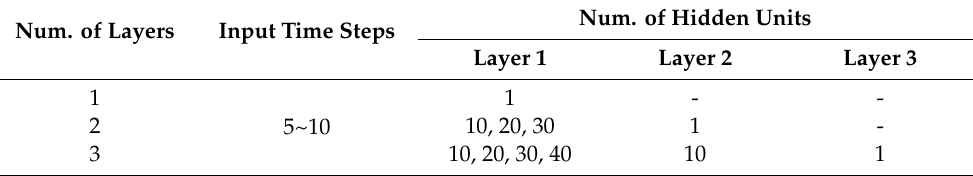
Table 4. A summary of di ff erent combinations of the hyperparameters in each scenario. Num. of Layers Input Time